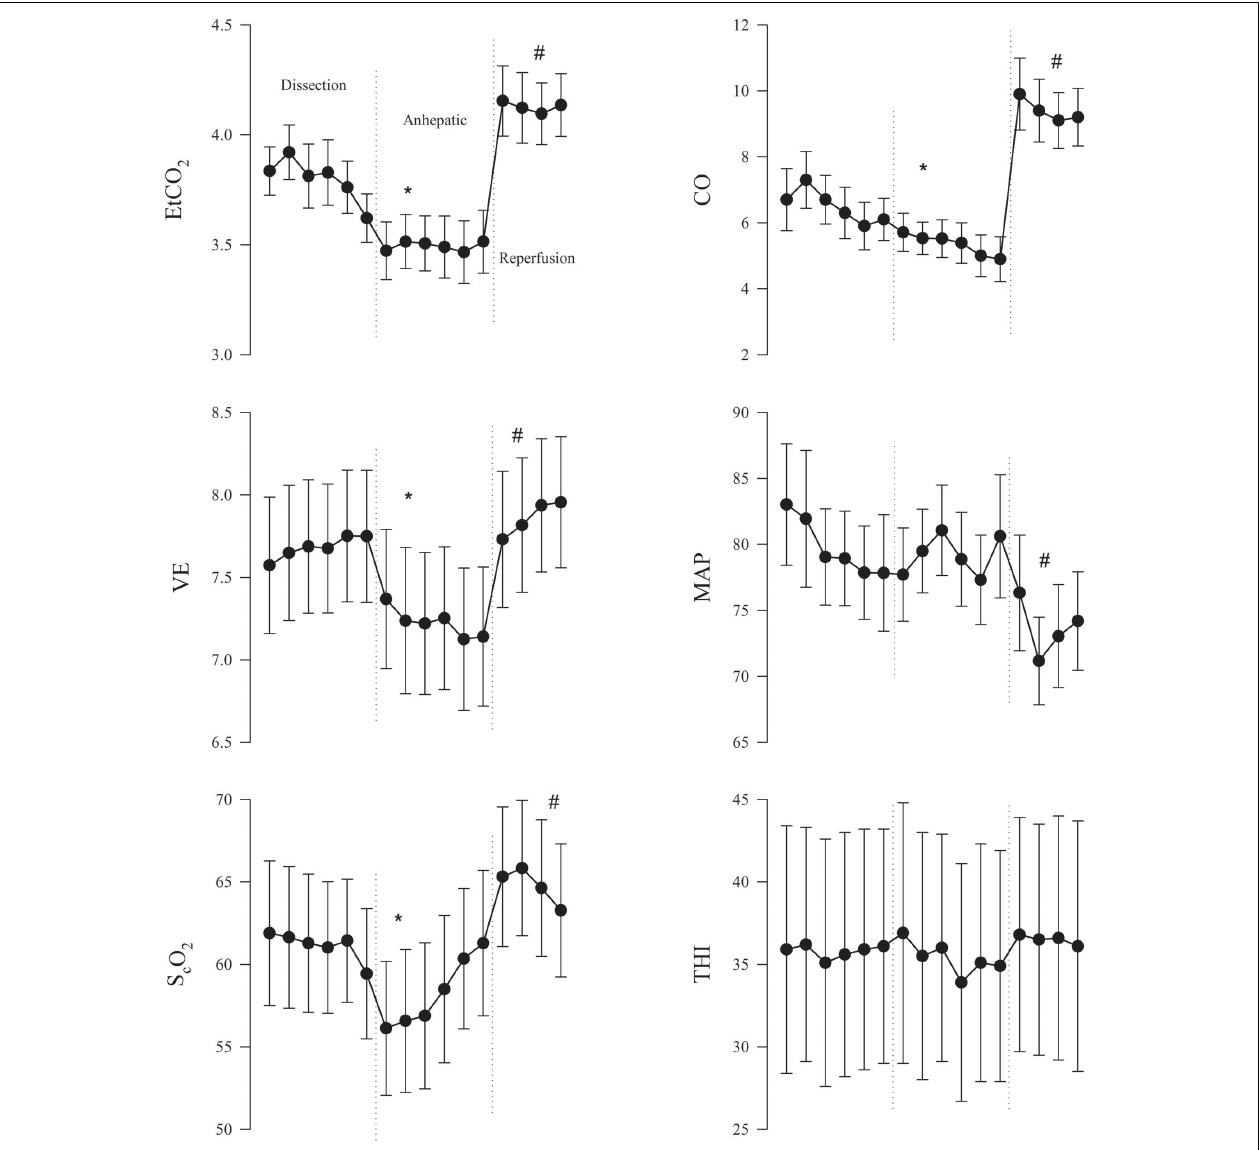
FIGURE 1 | Mean ( ± 95% confidence interval) for 10th min in the dissection, anhepatic and reperfusion phases of liver transplantation surgery for end-tidal CO 2 tension (EtCO 2 ); ventilation (VE); near infrared spectroscopy-determined frontal lobe oxygenation (S c O 2 ); cardiac